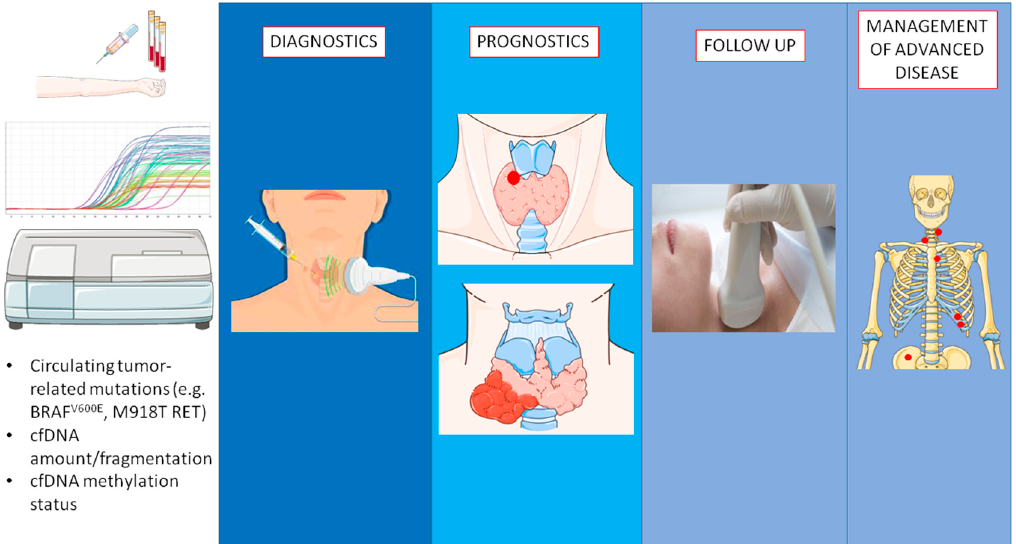
Figure 1. The diagnostic-therapeutic settings of thyroid cancer with the applicable cfDNA analyses. Parts of the figure were drawn by using pictures from Servier Medical Art (smart.servier.com (ac- cessed on 27 October 2022). Servier Medical Art by Servier is licensed under a Creative Commons Attribution 3.0 Unported License (https://creativecommons.org/licenses/by/3.0/ (accessed on 27 Oc- tober 2022).